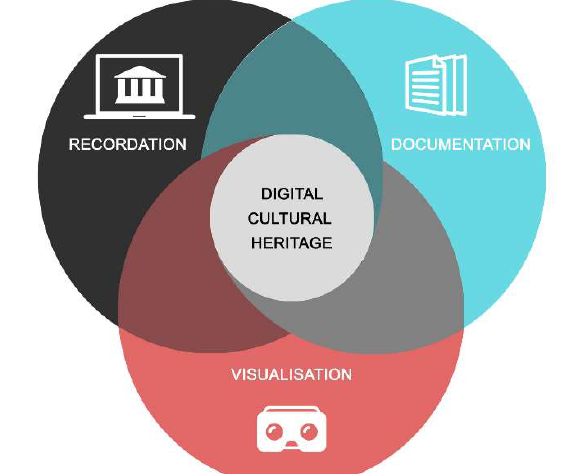
Figure 1. Use cases of digital cultural heritage (Ruffino,